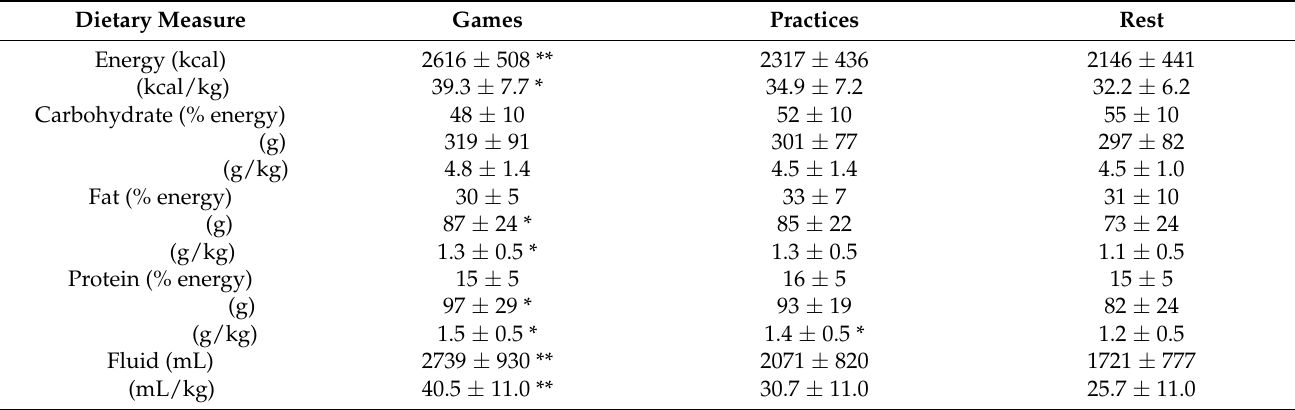
Table 2. Energy, macronutrient, and fluid intakes for game, practice, and rest days for varsity female ice hockey players.